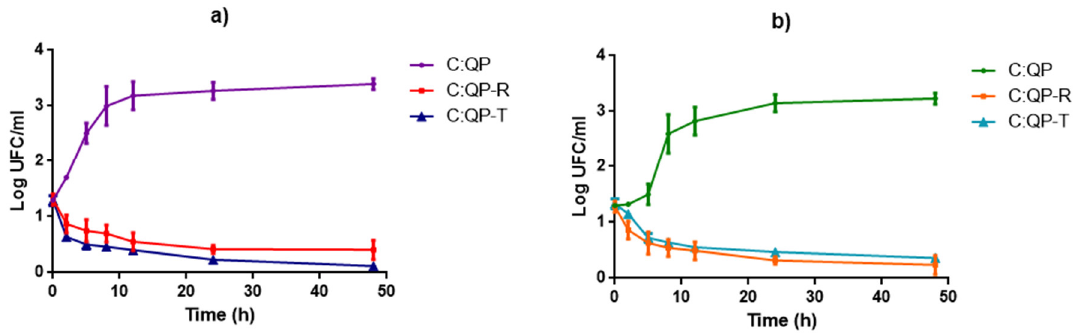
Figure 4. Antimicrobial activity of filmogenic suspensions with and without thyme and rosemary essential oils. ( a ) Micrococcus luteus , ( b ) Salmonella sp.